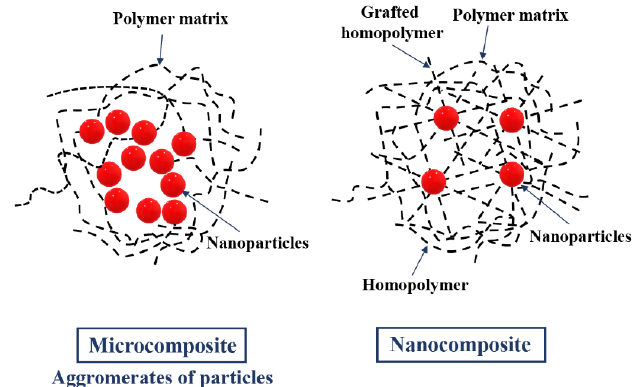
Figure 2. Structures of micro- and nanocomposites.